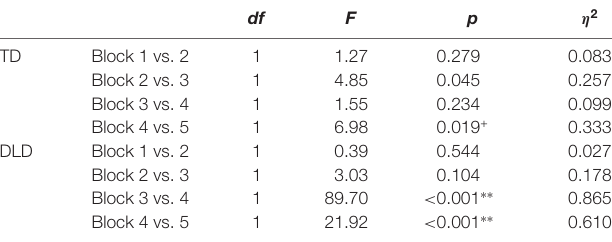
TABLE 3 | Within-subjects contrast analyses by groups, for the online accuracy measures in the acoustic verbal segmentation